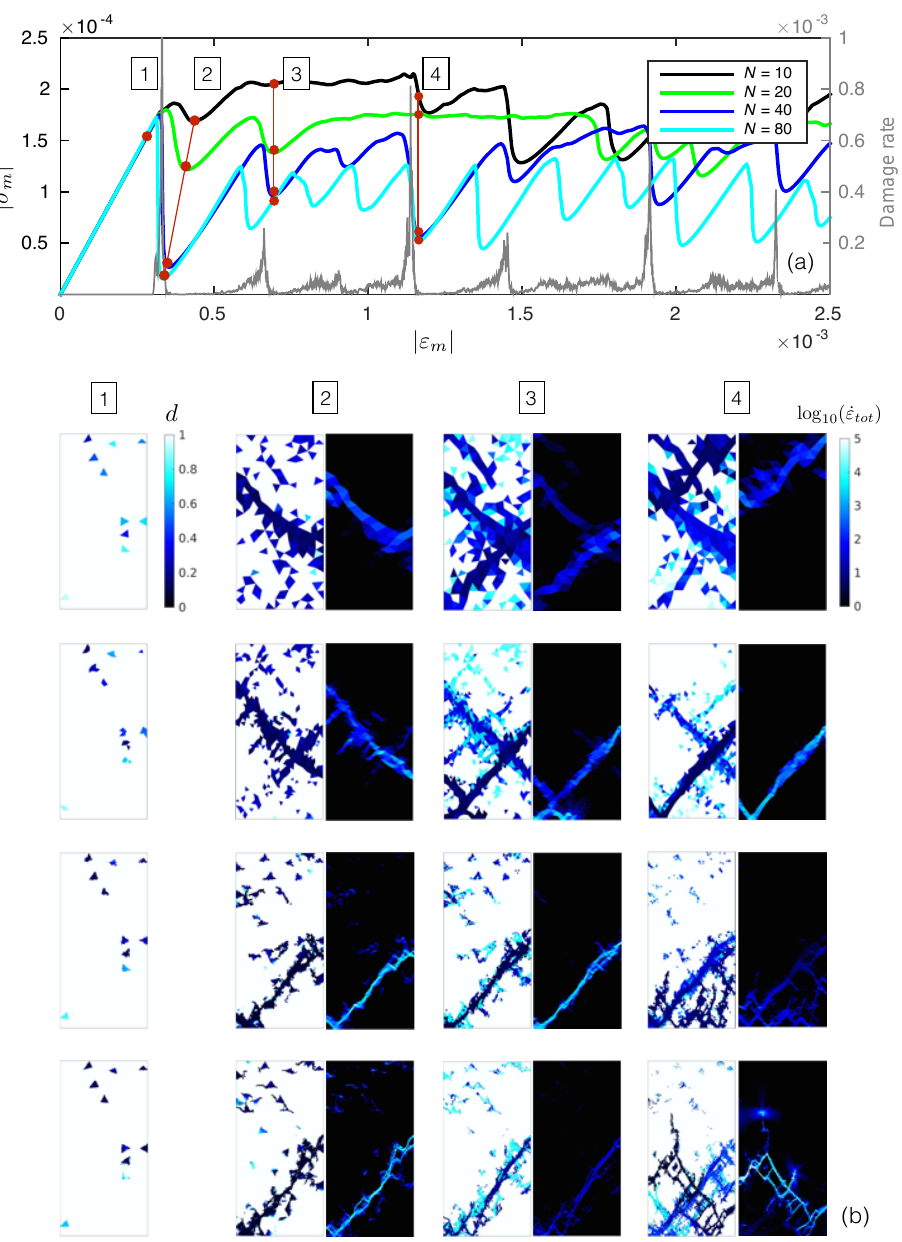
Figure 5. (a) Macroscopic stress vs. macroscopic strain (solid lines) for four uniaxial compression simulations with different spatial resolu- tions and damage rate (number of damaged elements times 1 − d crit , grey line) for the simulation with N = 40. All simulations are initialized with the same values of the mechanical parameters and with the same field of cohesion ( C ) defined at the lowest spatial resolution ( N = 10). (b) Fields of the instantaneous level of damage (left panels) and of the order of magnitude of the total deformation rate (log 10 ( ˙ ε tot ) , right panels) at the four different times indicated on (a) and for the four simulations (resolution increasing from top to